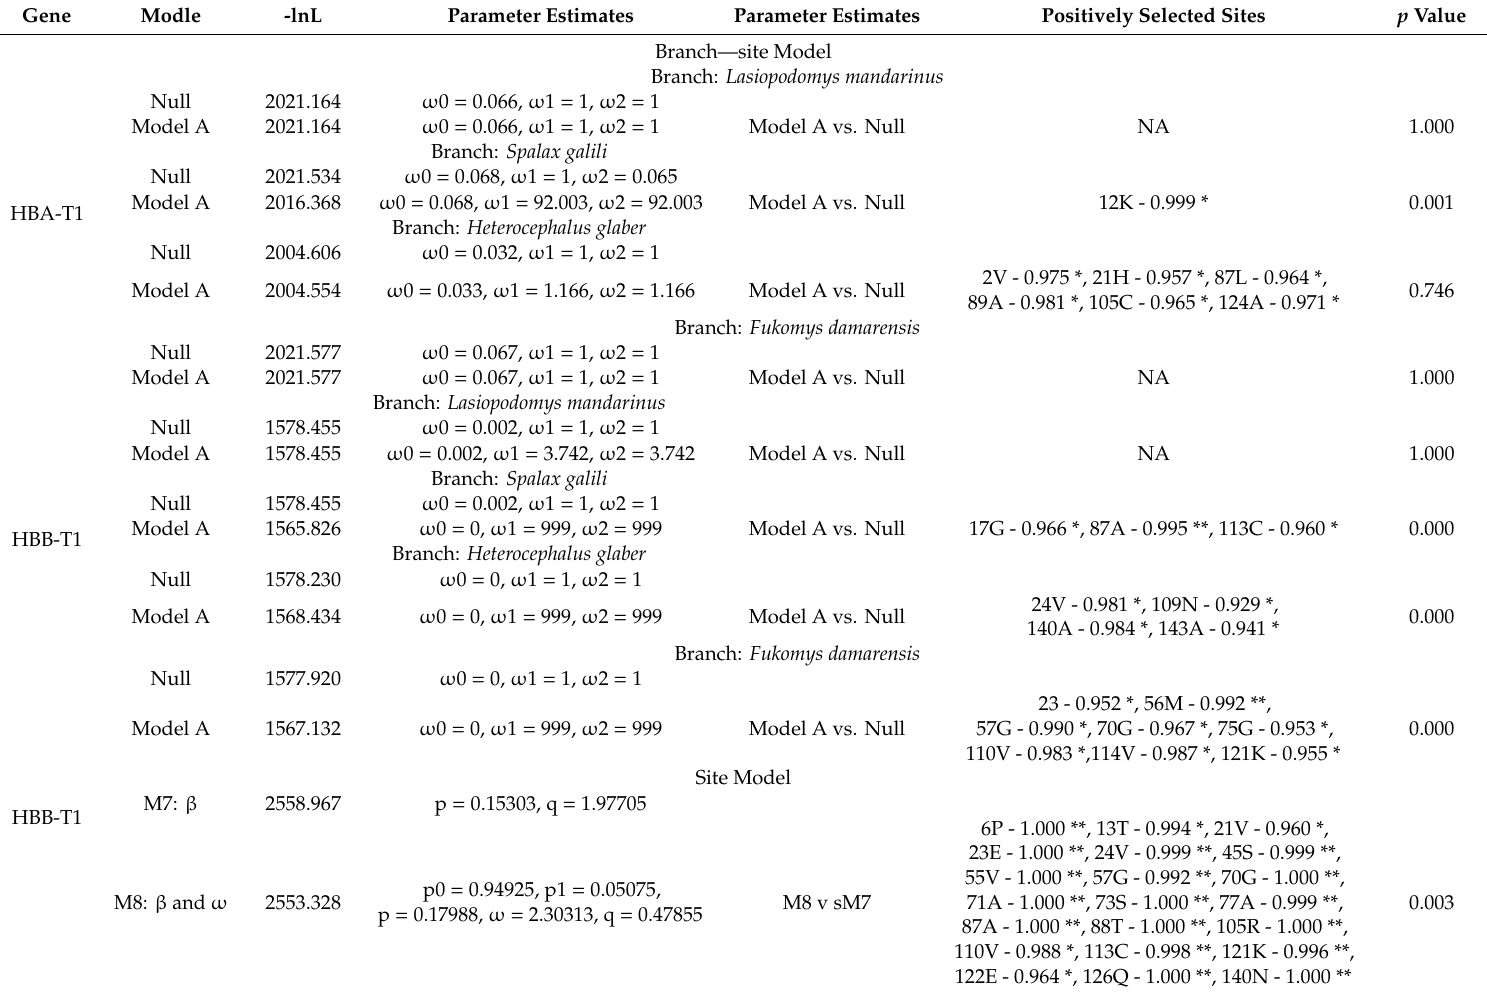
Table 2. Selection pressure analyses of Hb genes in rodent species using branch-site and site